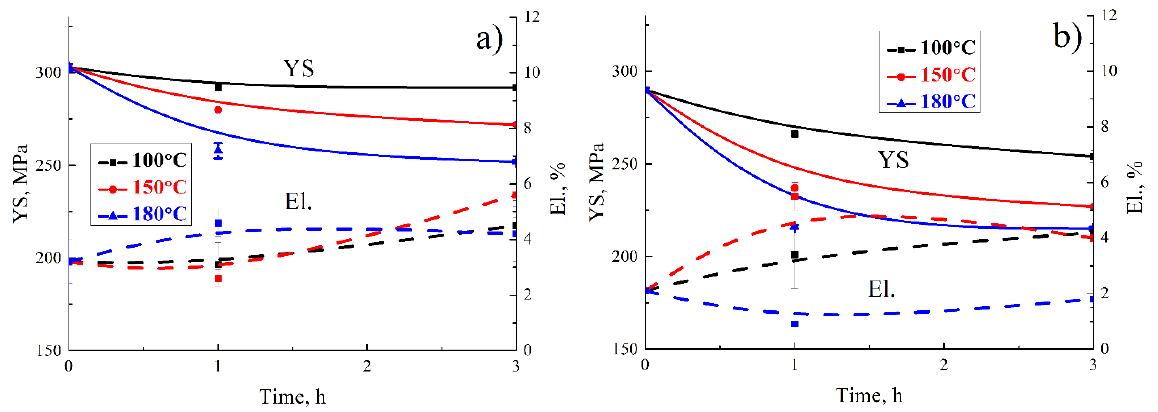
Figure 9. YS and El. dependencies vs. time after annealing at 100, 150 and 180 ◦ C for the ( a ) Al-Cu-Yb and ( b ) Al-Cu- Gd alloys